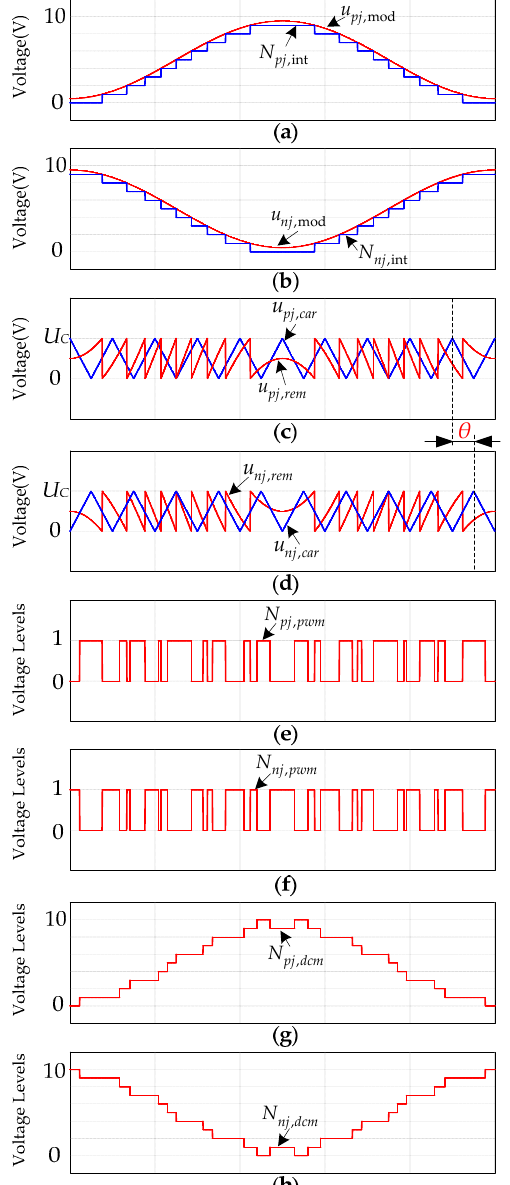
Figure 2. Principle of double-carrier phase-disposition pulse width modulation (DCPDPWM) for MMCs: ( a ) integer portion of the upper arm modulation signal; ( b ) integer portion of the lower arm modulation signal; ( c ) modulation of the remainder for the upper arm; ( d ) modulation of the remainder for the lower arm; ( e ) pulse width modulation (PWM) signal of the upper arm; ( f ) PWM signal of the lower arm; ( g ) number of on-state SMs for the upper arm; and ( h ) number of on-state SMs for the lower arm.